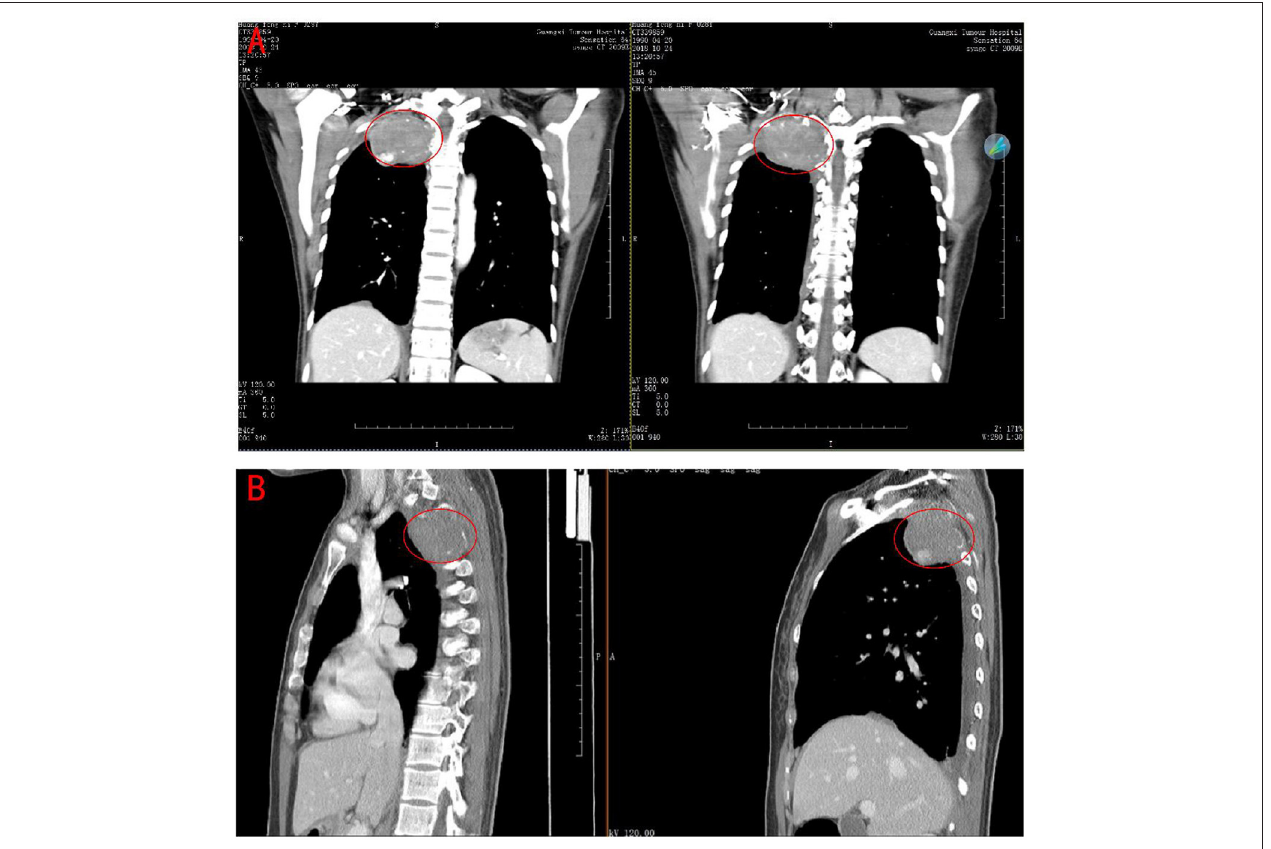
FIGURE 1 | Computerized Tomography scan of the chest revealed a large tumor on the right posterior upper chest wall. (A) coronal plane. (B) sagittal plane.